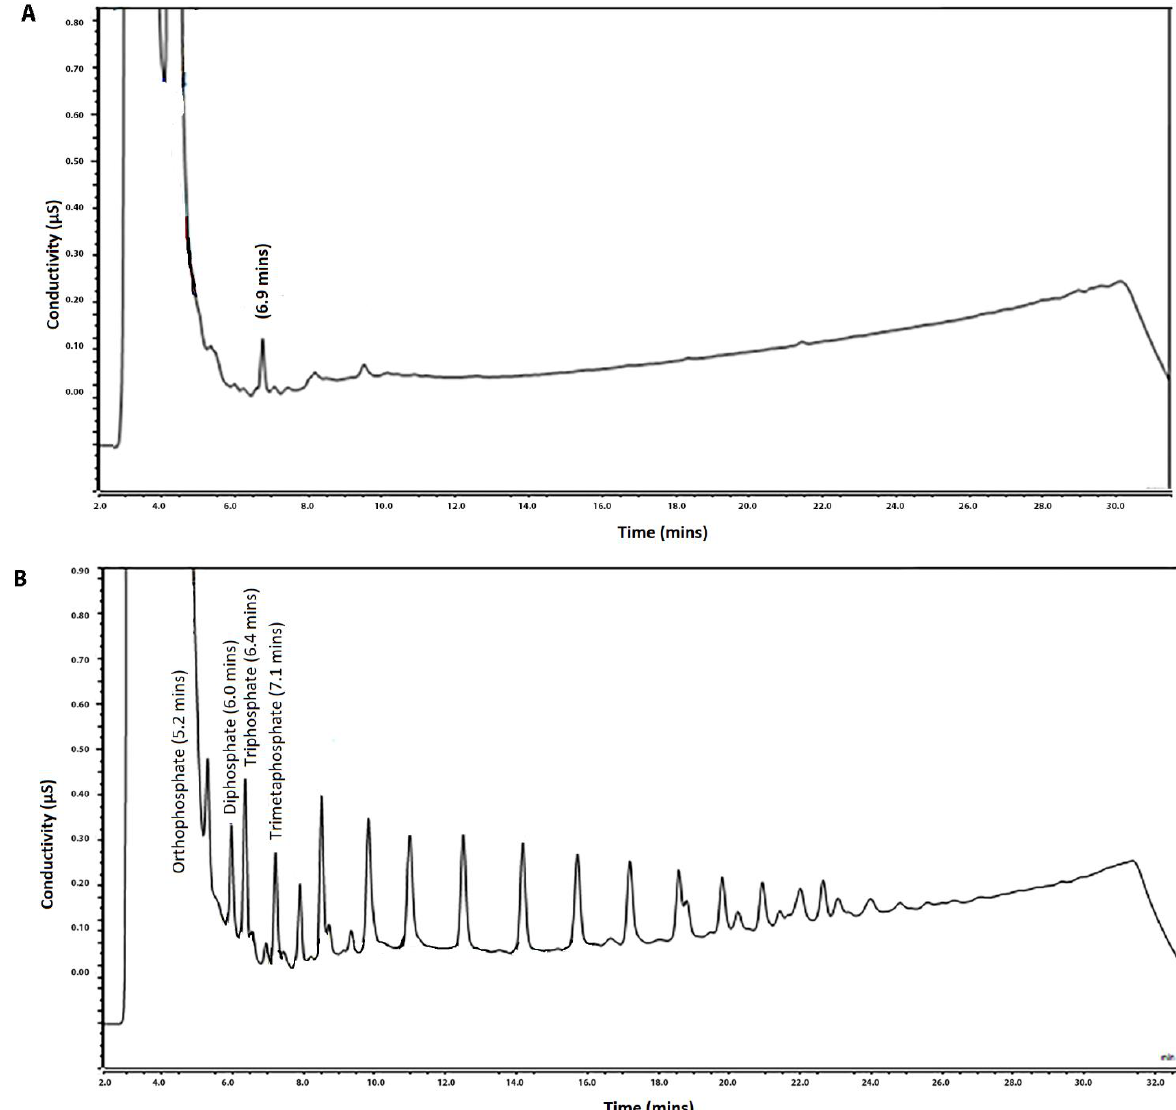
Figure 2. ( A ) Chromatogram of a blank dairy sample without any (poly)phosphate species detected. ( B ) Chromatogram of a blank dairy sample with SHMP added at LOD level (200 µg g − 1 ).